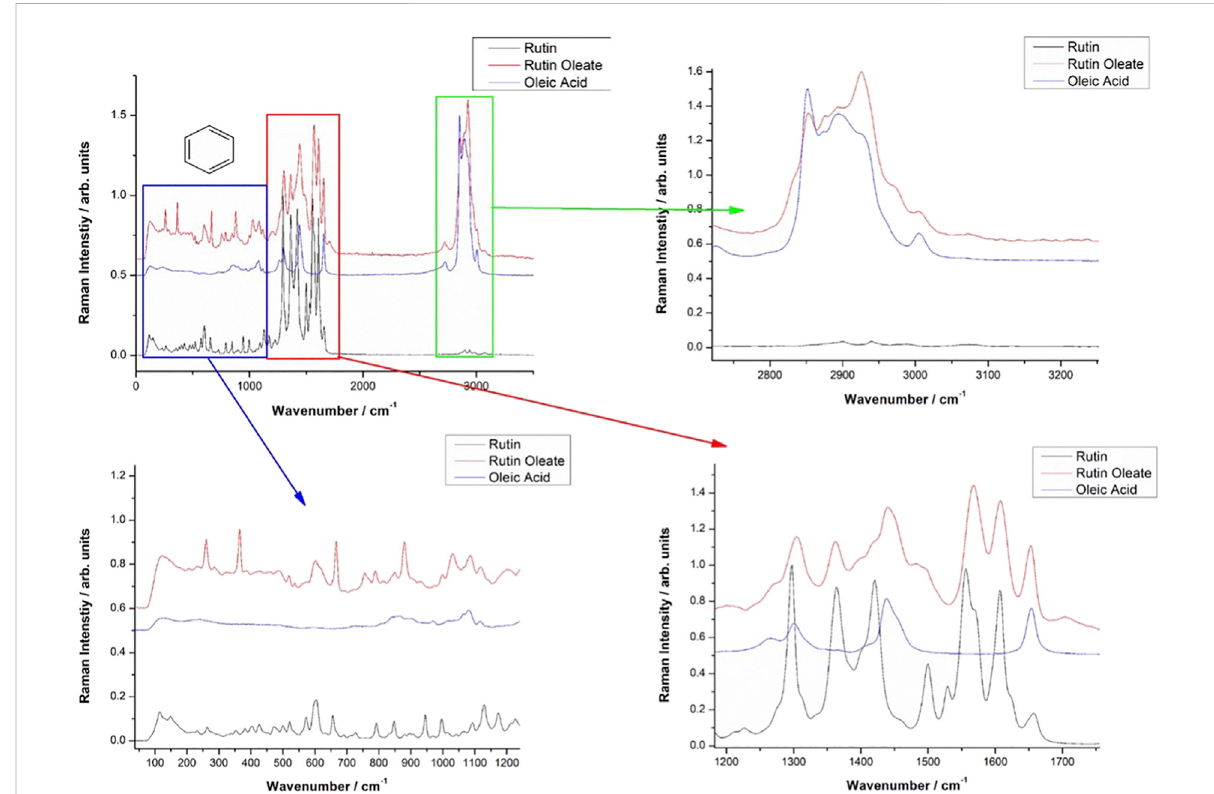
FIGURE 1 Comparative Raman spectra of Rutin (RUT), Oleic acid (OA) and Rutin oleate (RUT-O).